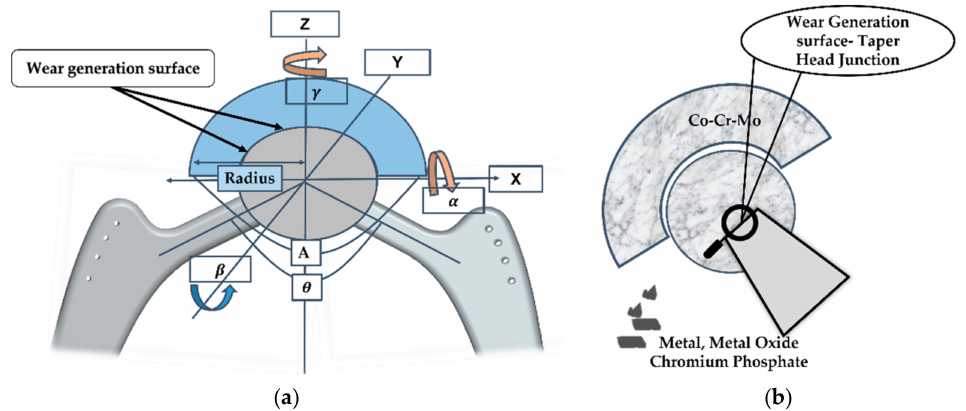
Figure 8. ( a ) Cross-sectional view of acetabular head–liner contact joint and ( b ) acetabular head—neck contact